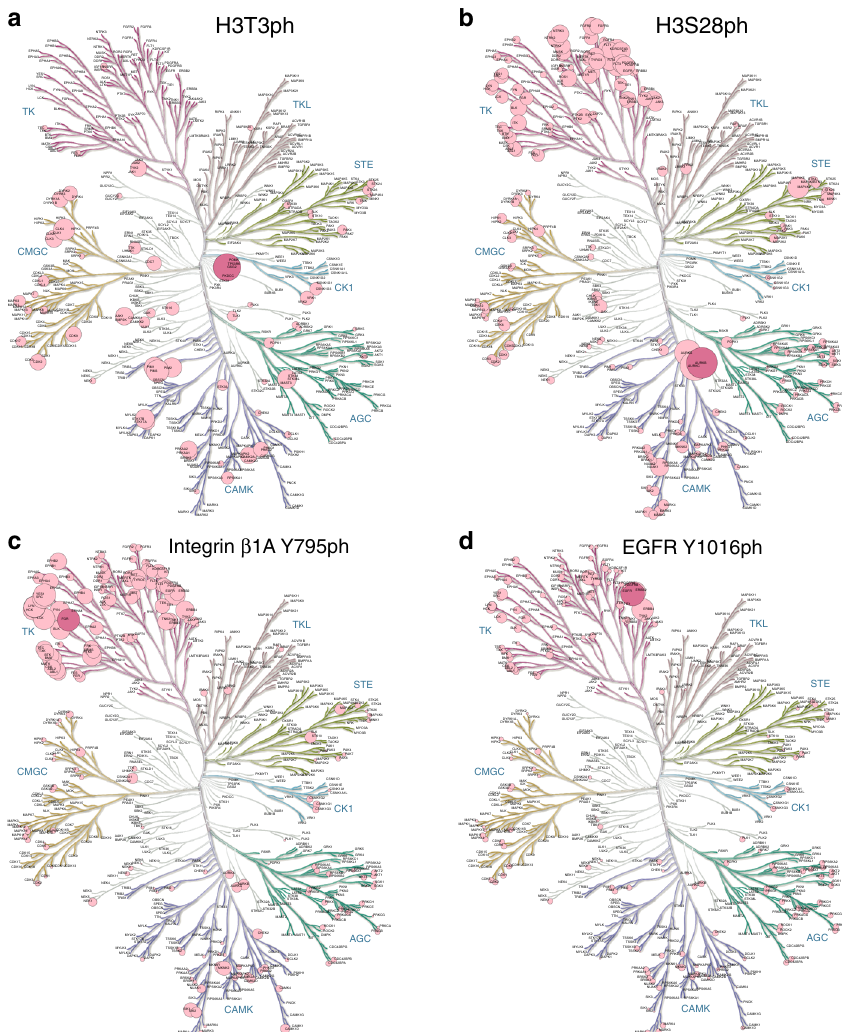
Fig. 7 KiPIK correlation coef fi cients for known kinases displayed on human kinome dendrograms. a H3T3ph results from the PKIS1/DSF dataset. b H3S28ph results from the PKIS1/Nanosyn 1 µ M dataset. c Integrin β 1 A Y795ph results from the PKIS1/Nanosyn 1 µ M dataset. d EGFR Y1016ph results from the PKIS1/Nanosyn 1 µ M dataset. Circle sizes indicate correlation coef fi cients (from no circle at ρ = 0 to the largest circle at ρ = 1). The expected kinase, and overall top hit in each screen, is shown in deep violet. Trees for all results can be found in Supplementary Figs. 13 – 18. Kinome trees were produced using KinMap 92 , and the underlying tree illustration is reproduced courtesy of Cell Signaling Technology, Inc. (www.cellsignal.com). Source data are provided as a Source Data